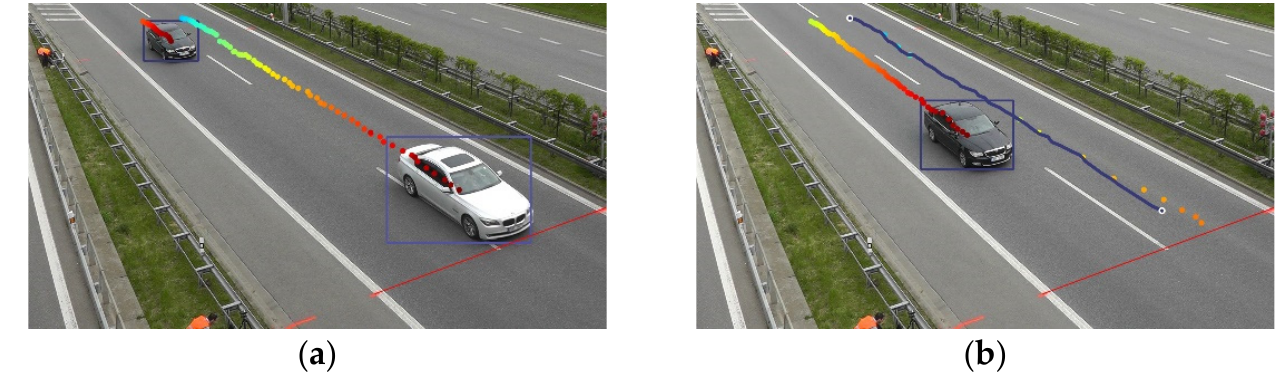
Figure 4. The age of the detection has been colour coded using the jet colormap: ( a ) A car is about to cross the goal line; ( b ) it has already crossed and the MVT algorithm has correctly found the detections that describe its trajectory, allowing it to measure the speed.